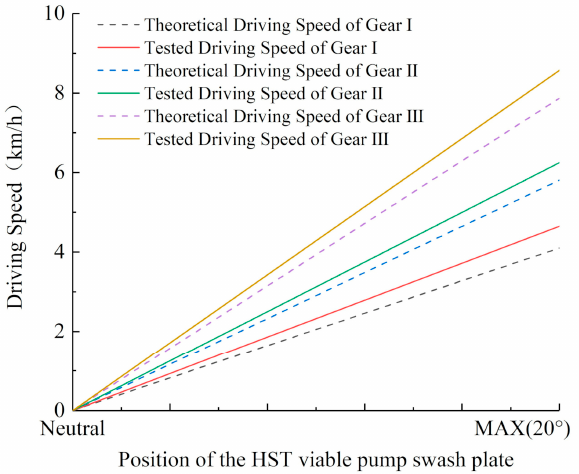
Figure 16. Comparison of the range of the driving speed of the tractor between the tested result and the theoretical calculation result.